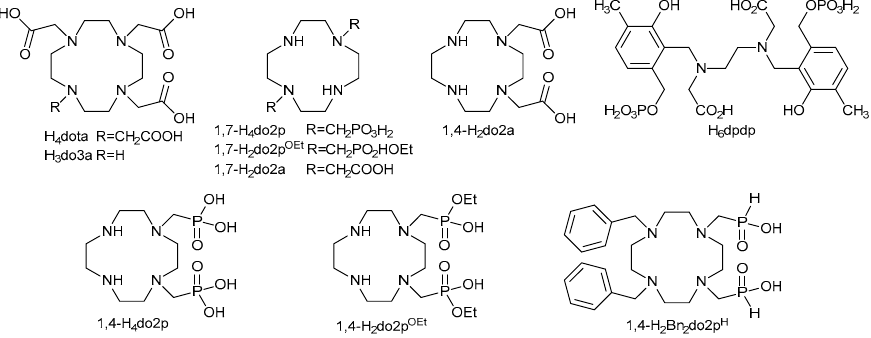
Figure 1. Structural formulas of the ligands discussed in the text.